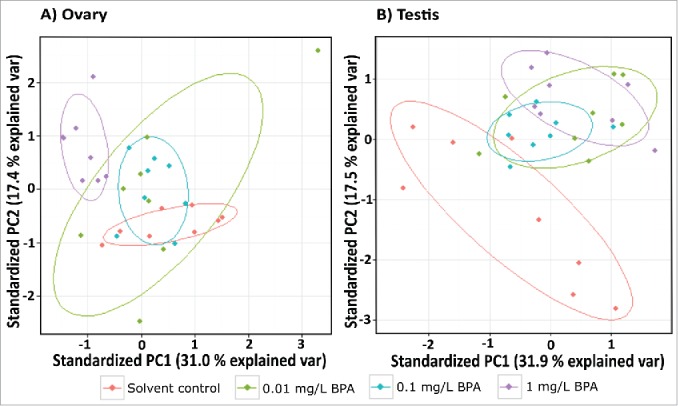
Principal components (PC) score plots showing the relative similarity of gonadal transcription profiles for zebrafish exposed to solvent, 0.01, 0.1, and 1 mg/L BPA for 15 d. A) Ovary. B) Testis. Points represent PC scores for individual fish along PCs 1 and 2. Circles represent a general characterization of the PC space occupied by each treatment group and were calculated using the prcomp package in R (version 3.0.2).